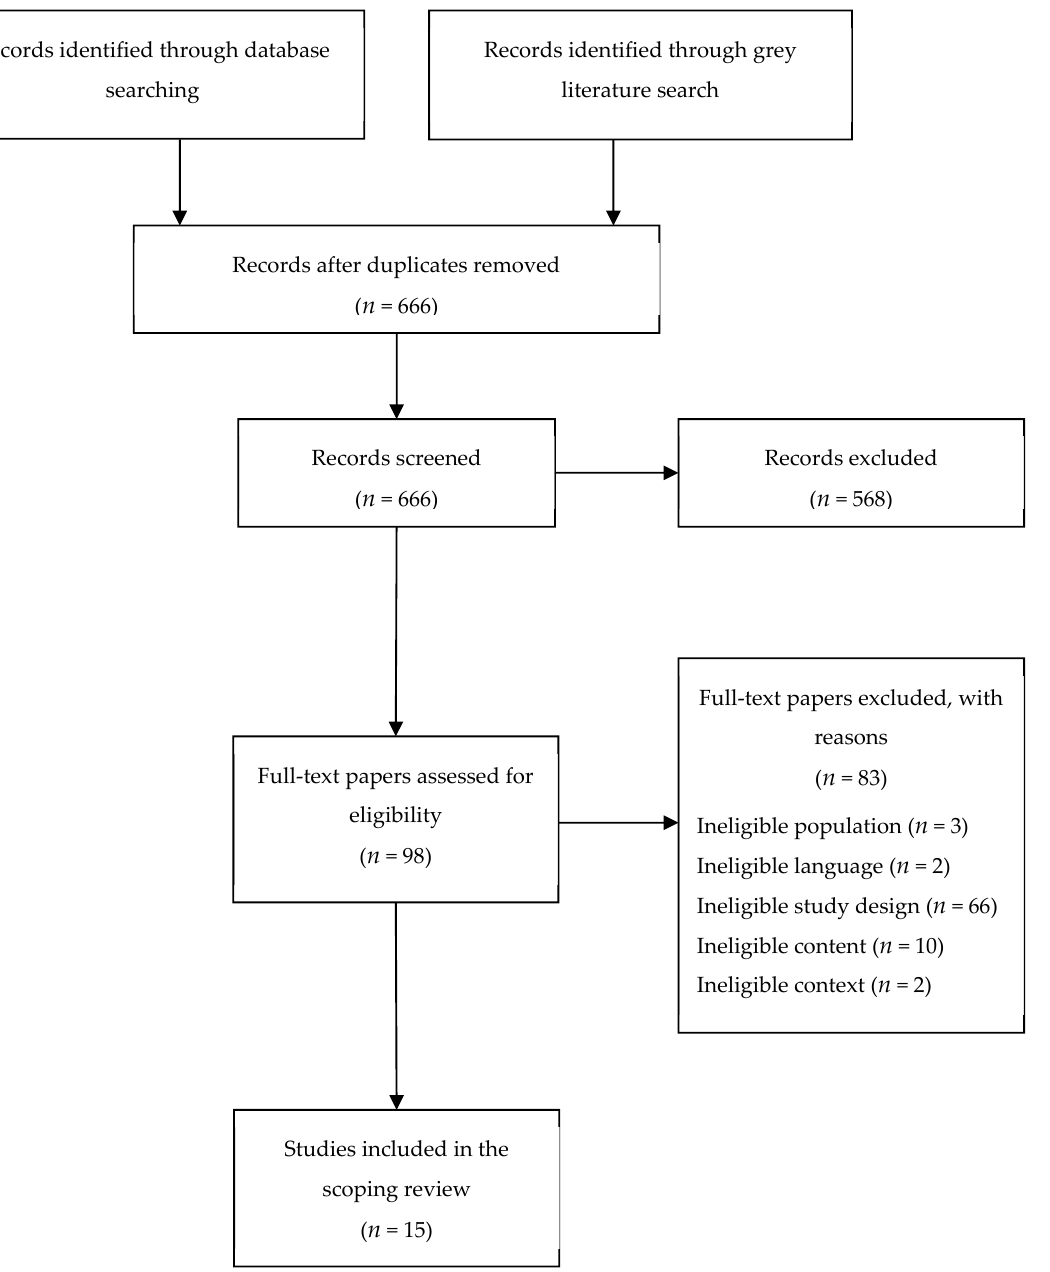
Figure 1. PRISMA flow diagram of included and excluded articles for scoping review.